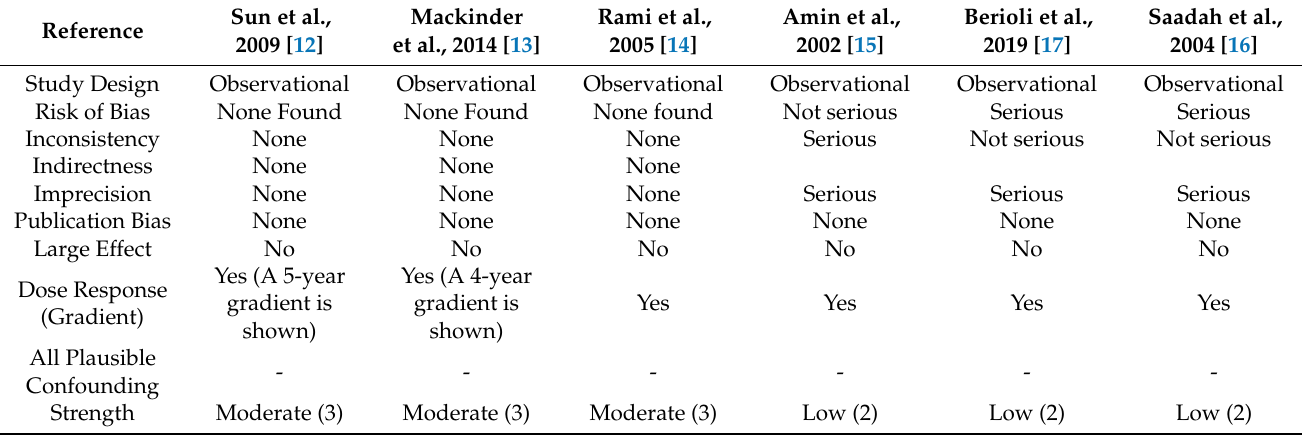
Table A1. Table of Quality Assessment